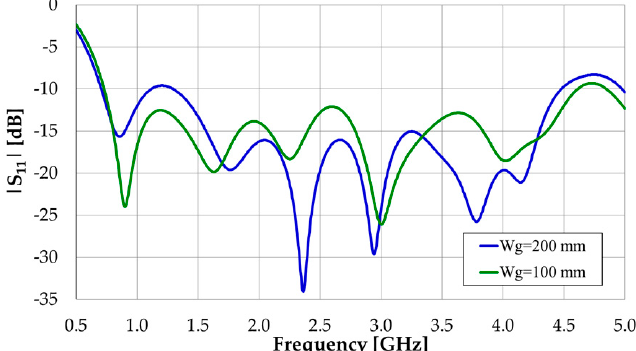
Figure 8. Input reflection coefficient amplitude simulation results of the modified octagonal monopole with CPW feed.